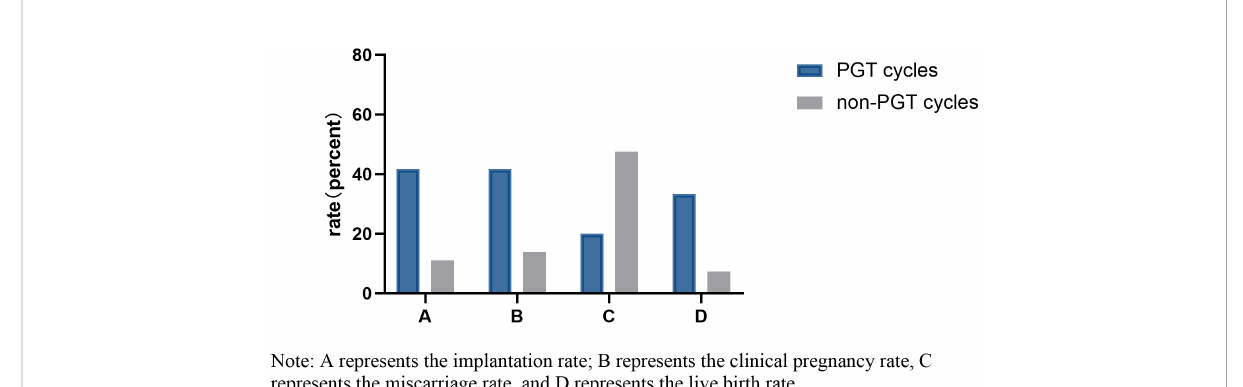
FIGURE 1 Clinical outcomes of D7 FET cycles from different sources.